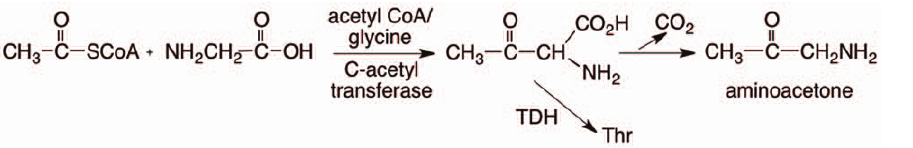
Figure 4. Condensation of acetyl-CoA and glycine to form the intermediate, 2-amino 3-ketobutyrate, a precursor of aminoacetone formation. Threonine dehydrogenase (TDH) normally catalyzes the reduction of 2-amino 3-ketobutyrate to form threonine and prevents its buildup; however, TDH is an inactive pseudo-gene in humans.